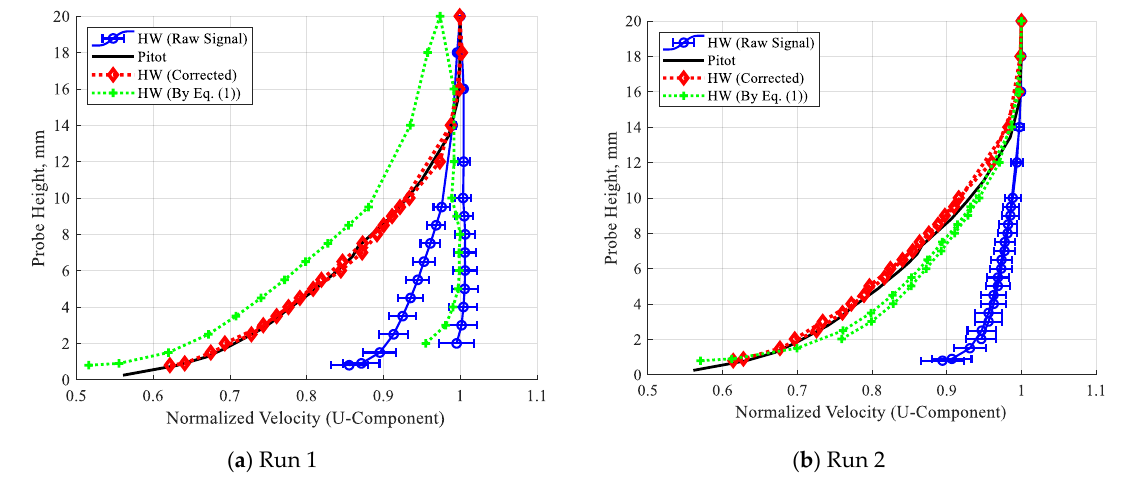
Figure 4. Representative comparison for velocity profiles obtained by hot-wire anemometry (raw, Figure4. Representativecomparisonforvelocityprofilesobtainedbyhot-wireanemometry(raw,calibrated calibrated by King’s law, and temperature-corrected by current method) and pitot-tube by King’s law, and temperature-corrected by current method) and pitot-tube measurement.